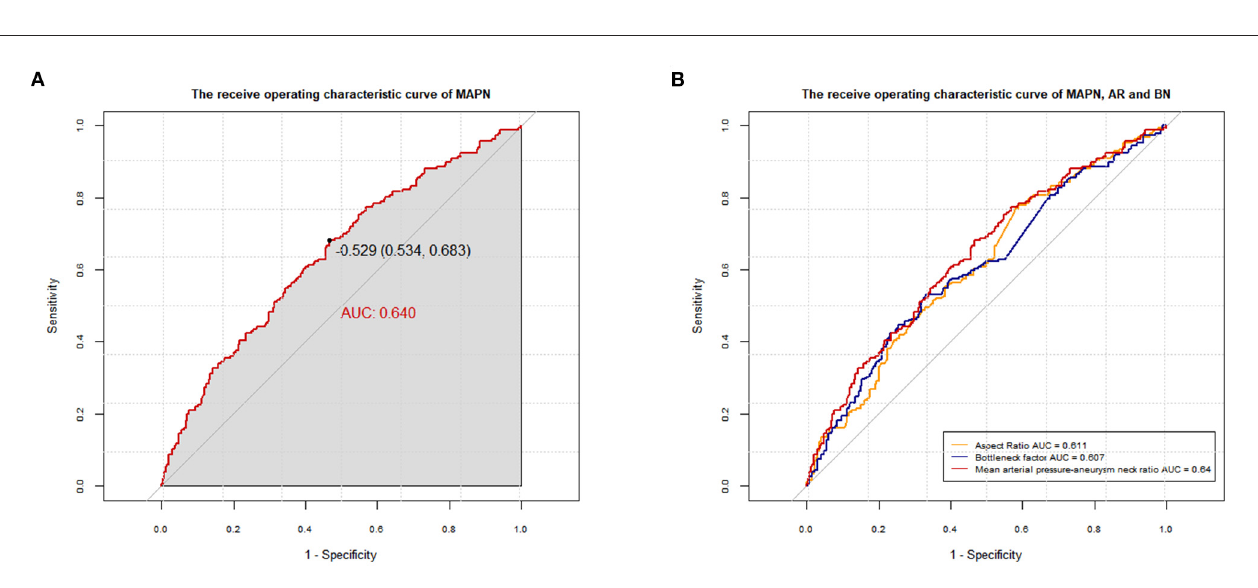
FIGURE3 (A) The AUC of the MAPN is 0.640 ( p < 0.001; 95% CI, 0.588–0.691) in the training set. (B) Comparison of the diagnostic capabilities between MAPN, AR and BN, and their AUC values were 0.64, 0.611 ( p < 0.001; 95% CI, 0.559–0.664) and 0.607 ( p < 0.001; 95% CI, 0.554–0.660),